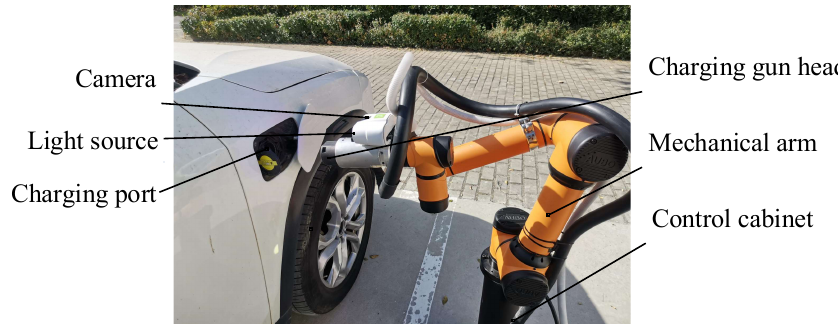
Figure 1. Internal structure diagram and relative position coordinates of a CP.